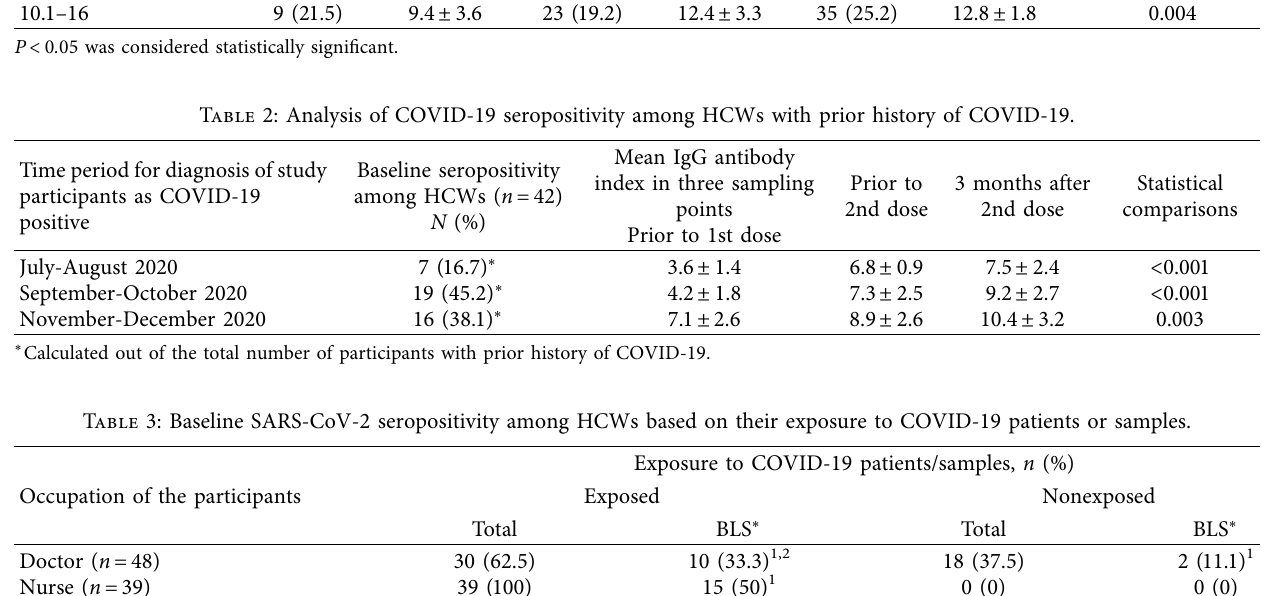
Table 1: Detection of SARS-CoV-2 IgG antibodies among healthcare workers at various sampling points. Sampling point for SARS-CoV-2 IgG antibody detection Antibody index range Prior to 1 st dose